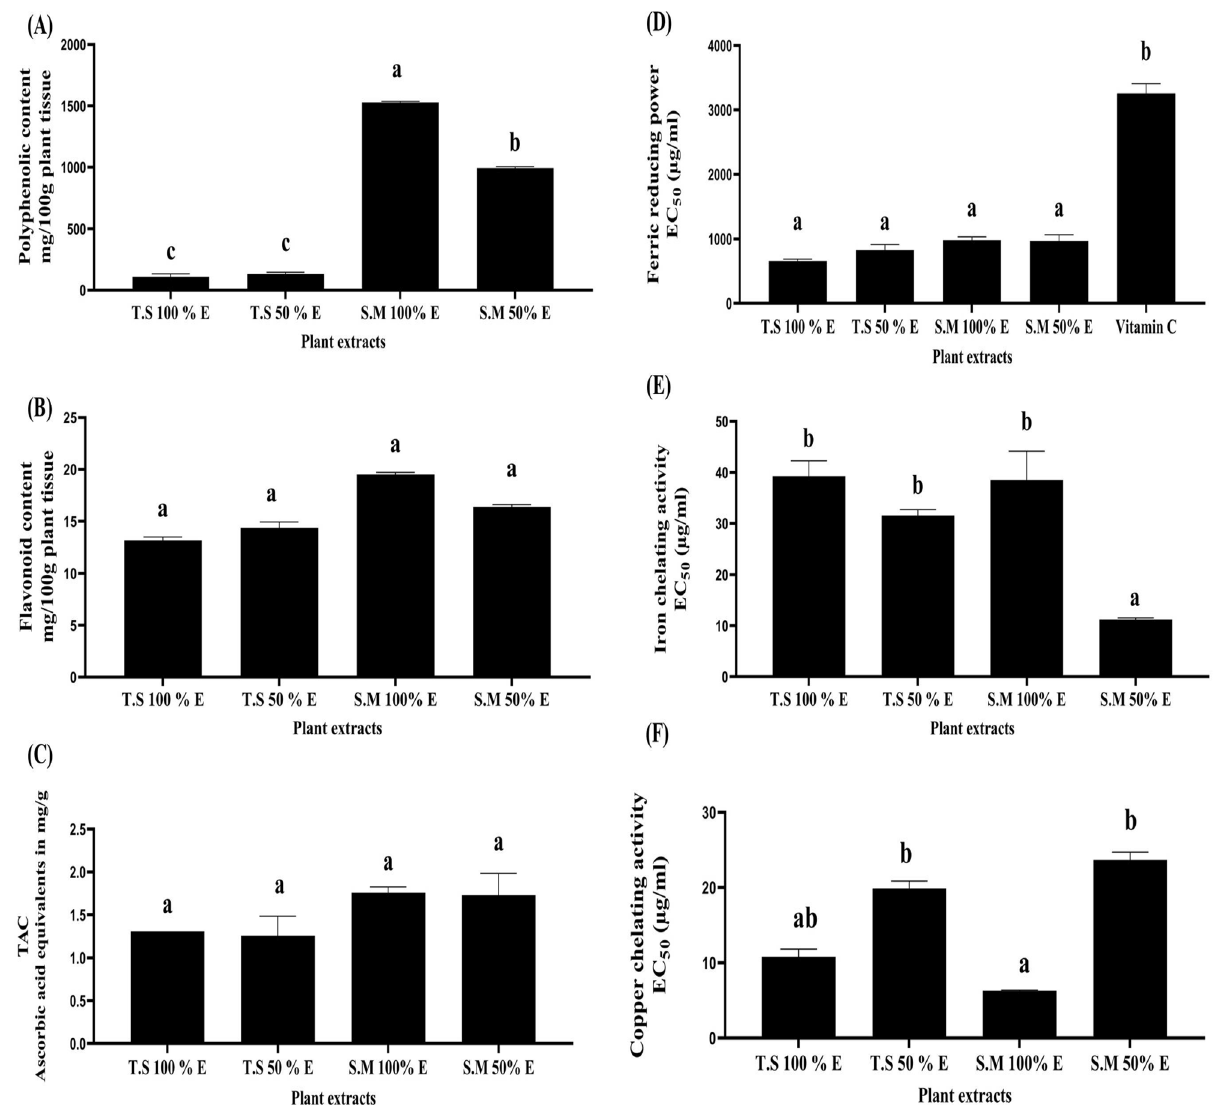
Figure 1. Phyto-chemicals and total antioxidant contents as well as iron reducing and metal chelating potentials in each examined ethanolic plant extract. ( A ) Phenolic content (mg/100 g plant tissue), ( B ) Flavonoid content (mg/100 g plant tissue), and ( C ) Total antioxidant content (ascorbic acid equivalents in mg/g). ( D ) Ferric reducing power (EC 50 : µg/mL) ( E ) Iron chelating activity (EC 50 : µg/mL) and ( F ) Copper chelating activity (EC 50 : µg/mL). All data are expressed as mean ± SEM. Different letters are significantly different at p ≤